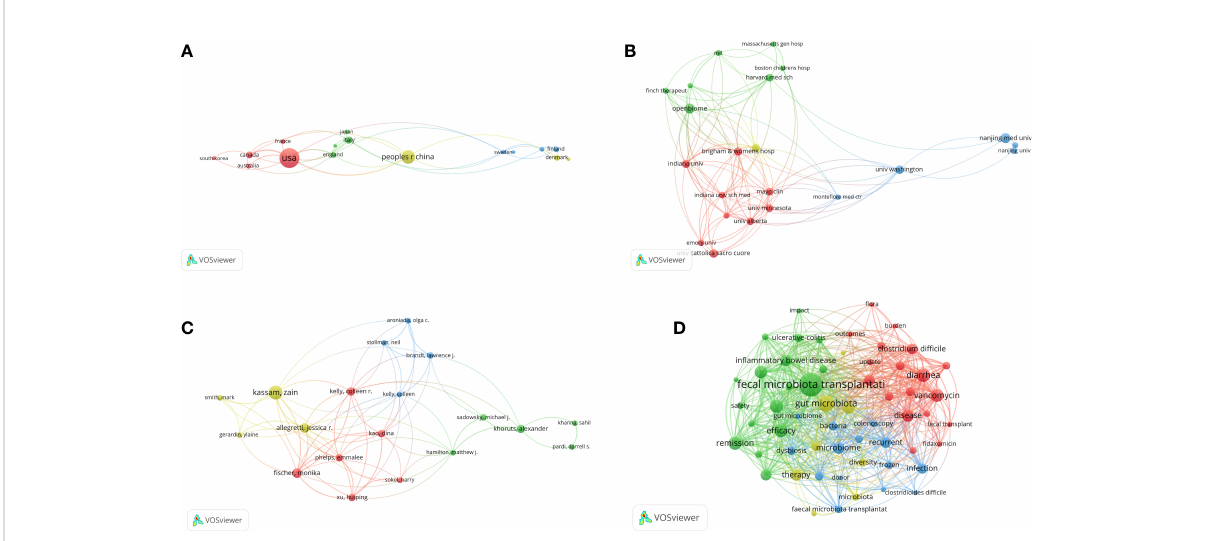
FIGURE 3 The cooperation network of countries/regions (A) , institutions (B) , and scholars (C) in the fi eld of FMT. The network visualization of the keywords (D) . The nodes denoted elements such as countries/regions, institutions, authors, or keywords. Larger nodes represented higher number of publications or occurrences, and the more links among different nodes indicated the stronger correlations.